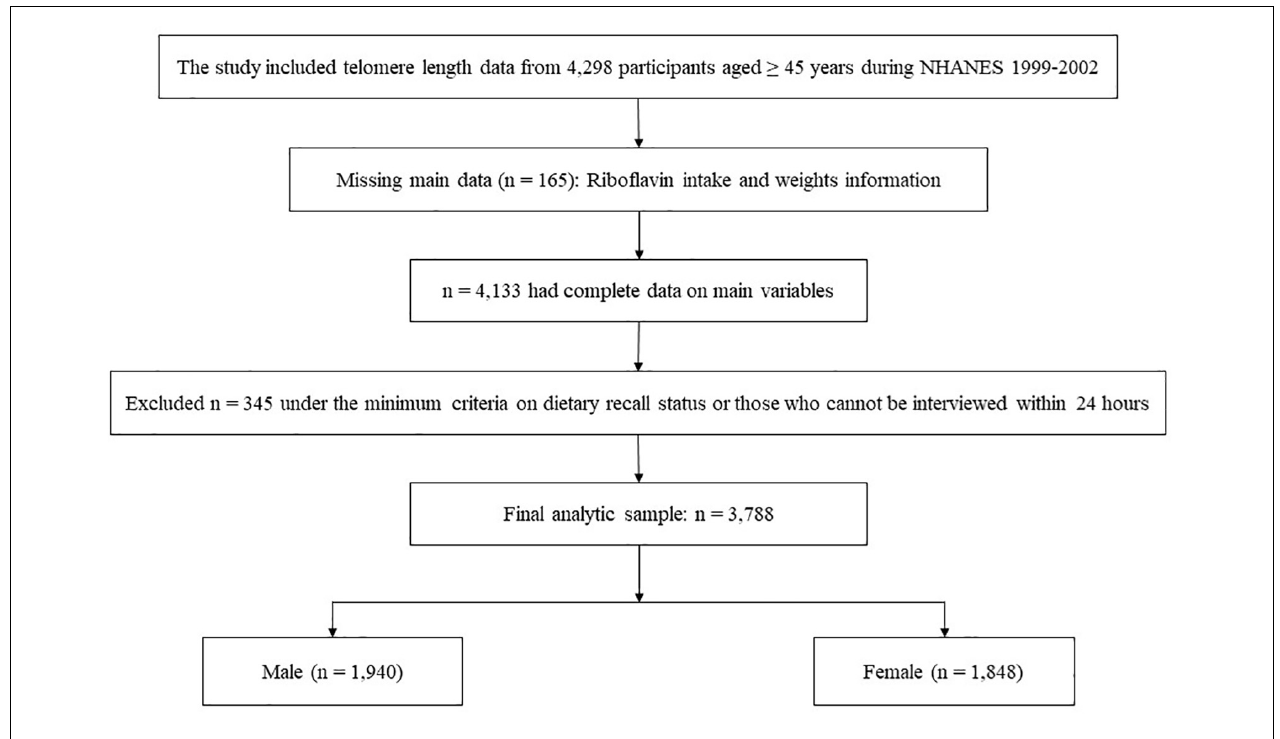
FIGURE 1 | NHANES 1999–2002 analytic sample flow